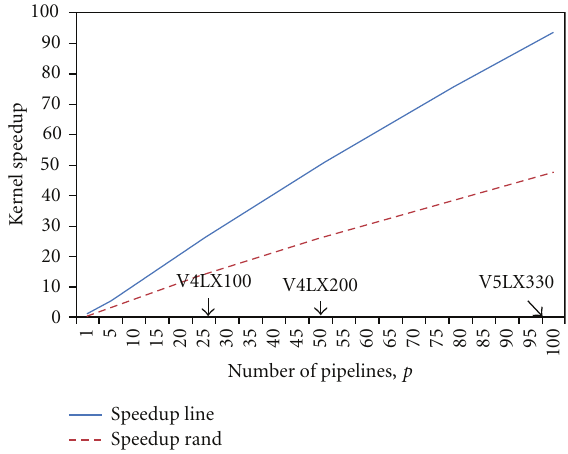
Figure 9: N-body kernel speedup obtained by the traversal cache framework for di ff erent amounts of datapath replication p . Note that for high similarity, speedup increases almost linearly due to the framework exploiting similarity between traversals to eliminate the memory bandwidth bottleneck . N = 100k, theta =